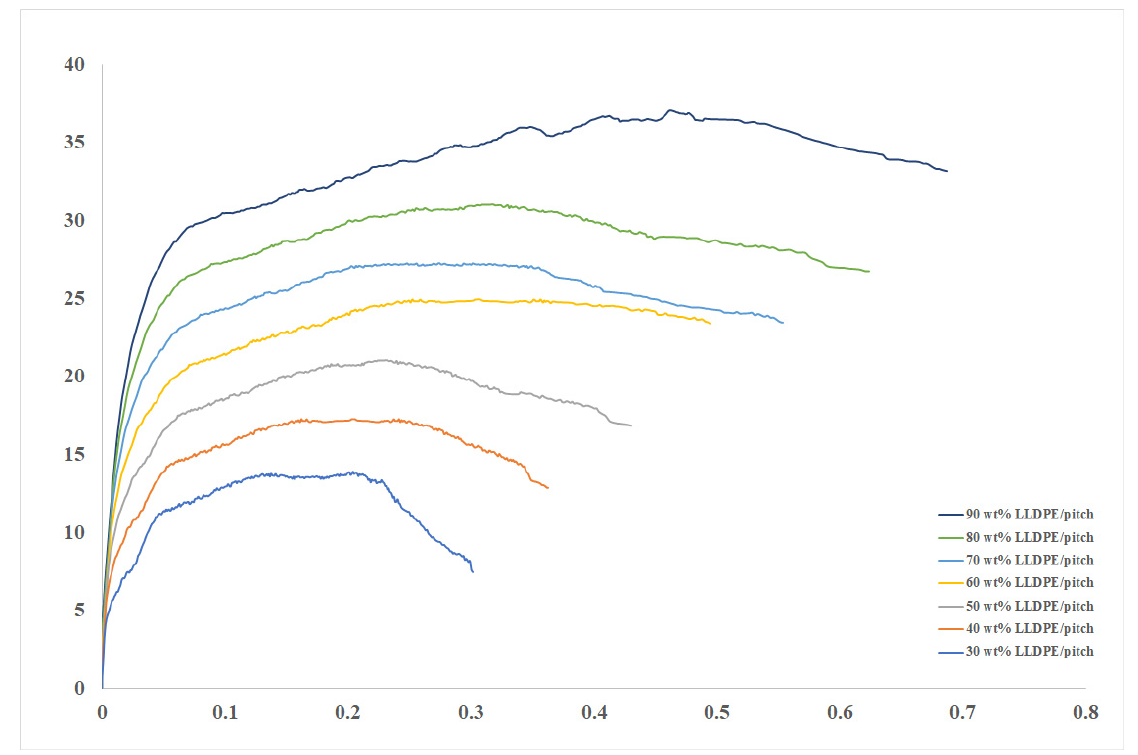
Figure 5. Tensile strength of LLDPE/MP fibres with differing wt% LLDPE content. Table 2. Tensile strength, modulus, and strain to failure of LLDPE/MP fibres with different wt% LLDPE (figures in brack- ets represent the standard deviation).